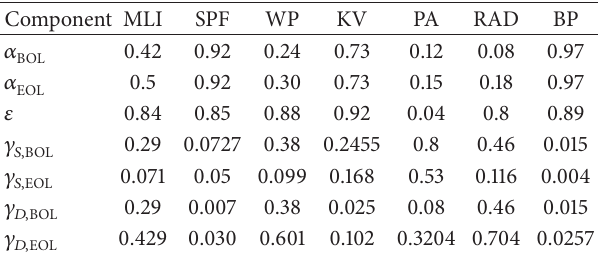
Table 2: Considered BOL and EOL values for 𝛼 , 𝜀 , 𝛾 𝑆 , and 𝛾 𝐷 . MLI: Multilayer Insulation, SPF: Solar Panel Front, WP: White Paint, KV: Kevlar, PA: Polished Aluminum, RAD: Radiator surface, and BP: Black